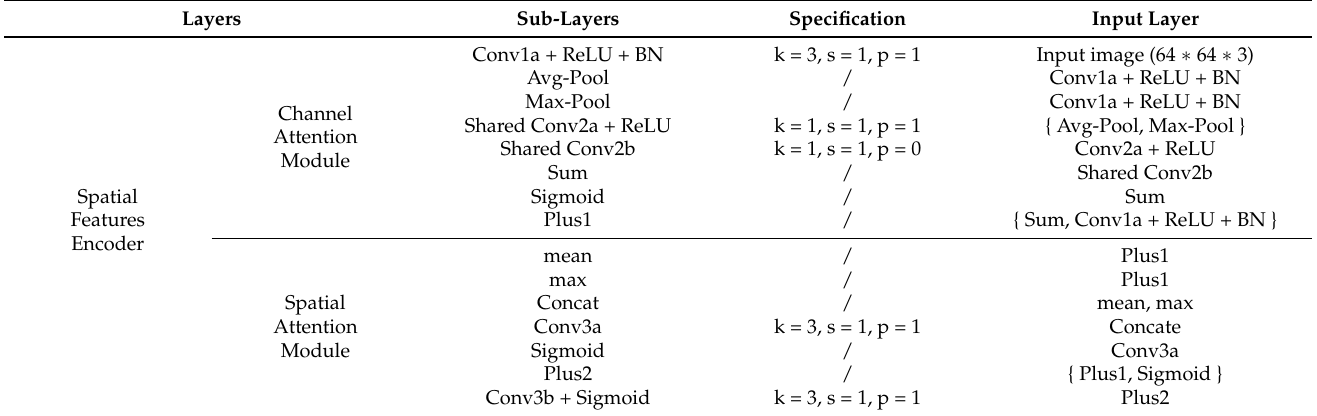
Table A1. Network architecture of the RL